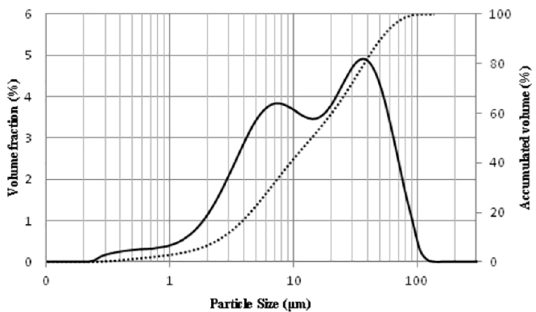
Figure 1. Particle size distribution of the EAFD.